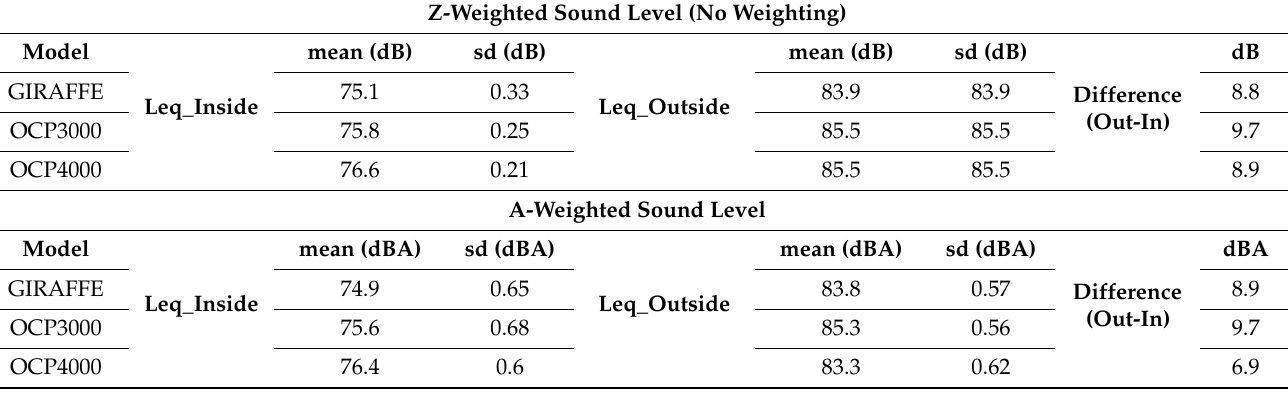
Table 4. The overall noise level inside and outside of the incubators (Incubators on; external sound source on).